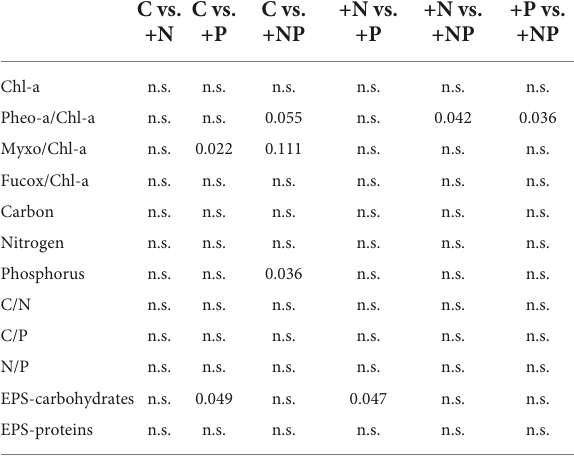
TABLE 2 The post hoc test ( p -values) for differences in pigments, elemental composition, and EPS content between the different experimental